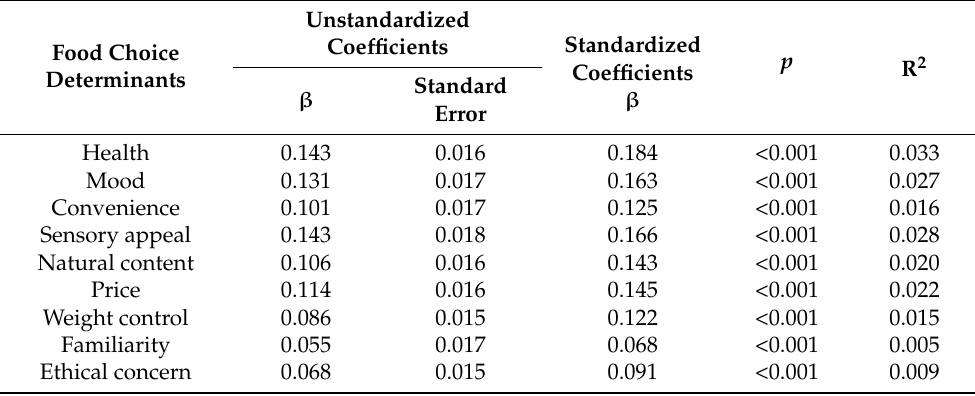
Table 8. Analysis of association between food choice determinants assessed by Food Choice Ques- tionnaire (FCQ) and starches preferences assessed by Food Preference Questionnaire (FPQ) (model adjusted for sex and age) within the population of the second phase of the Polish Adolescents’ COVID-19 Experience (PLACE-19) Study ( n =